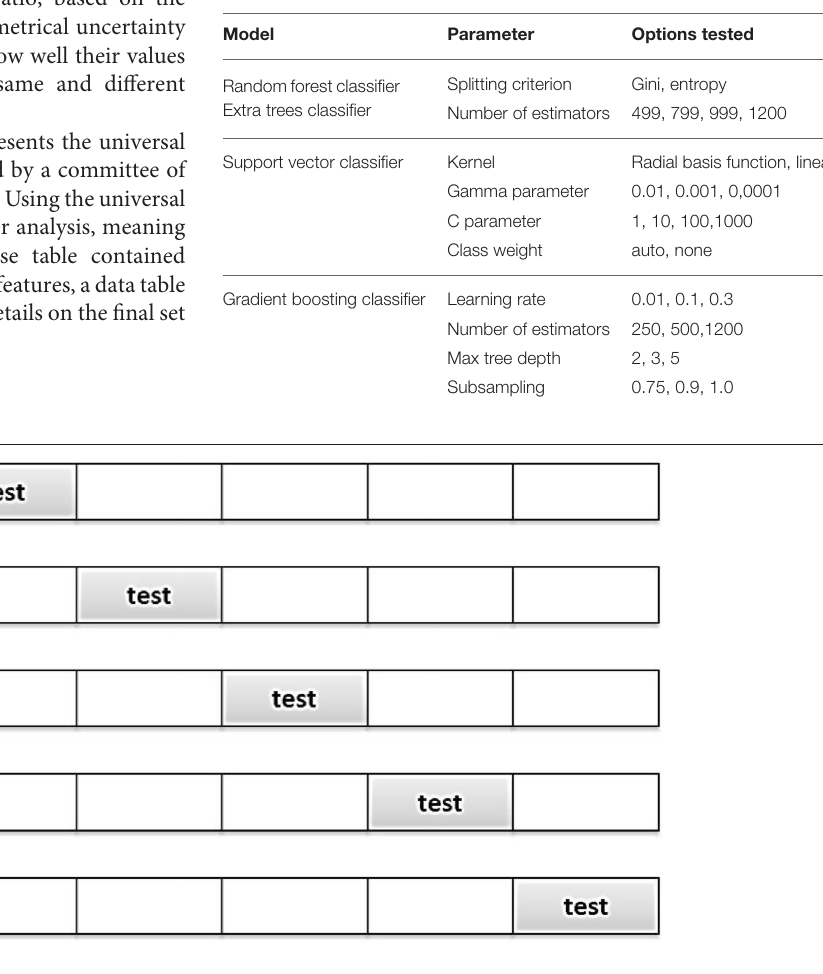
TABLE 2 | Searching the parameter space.